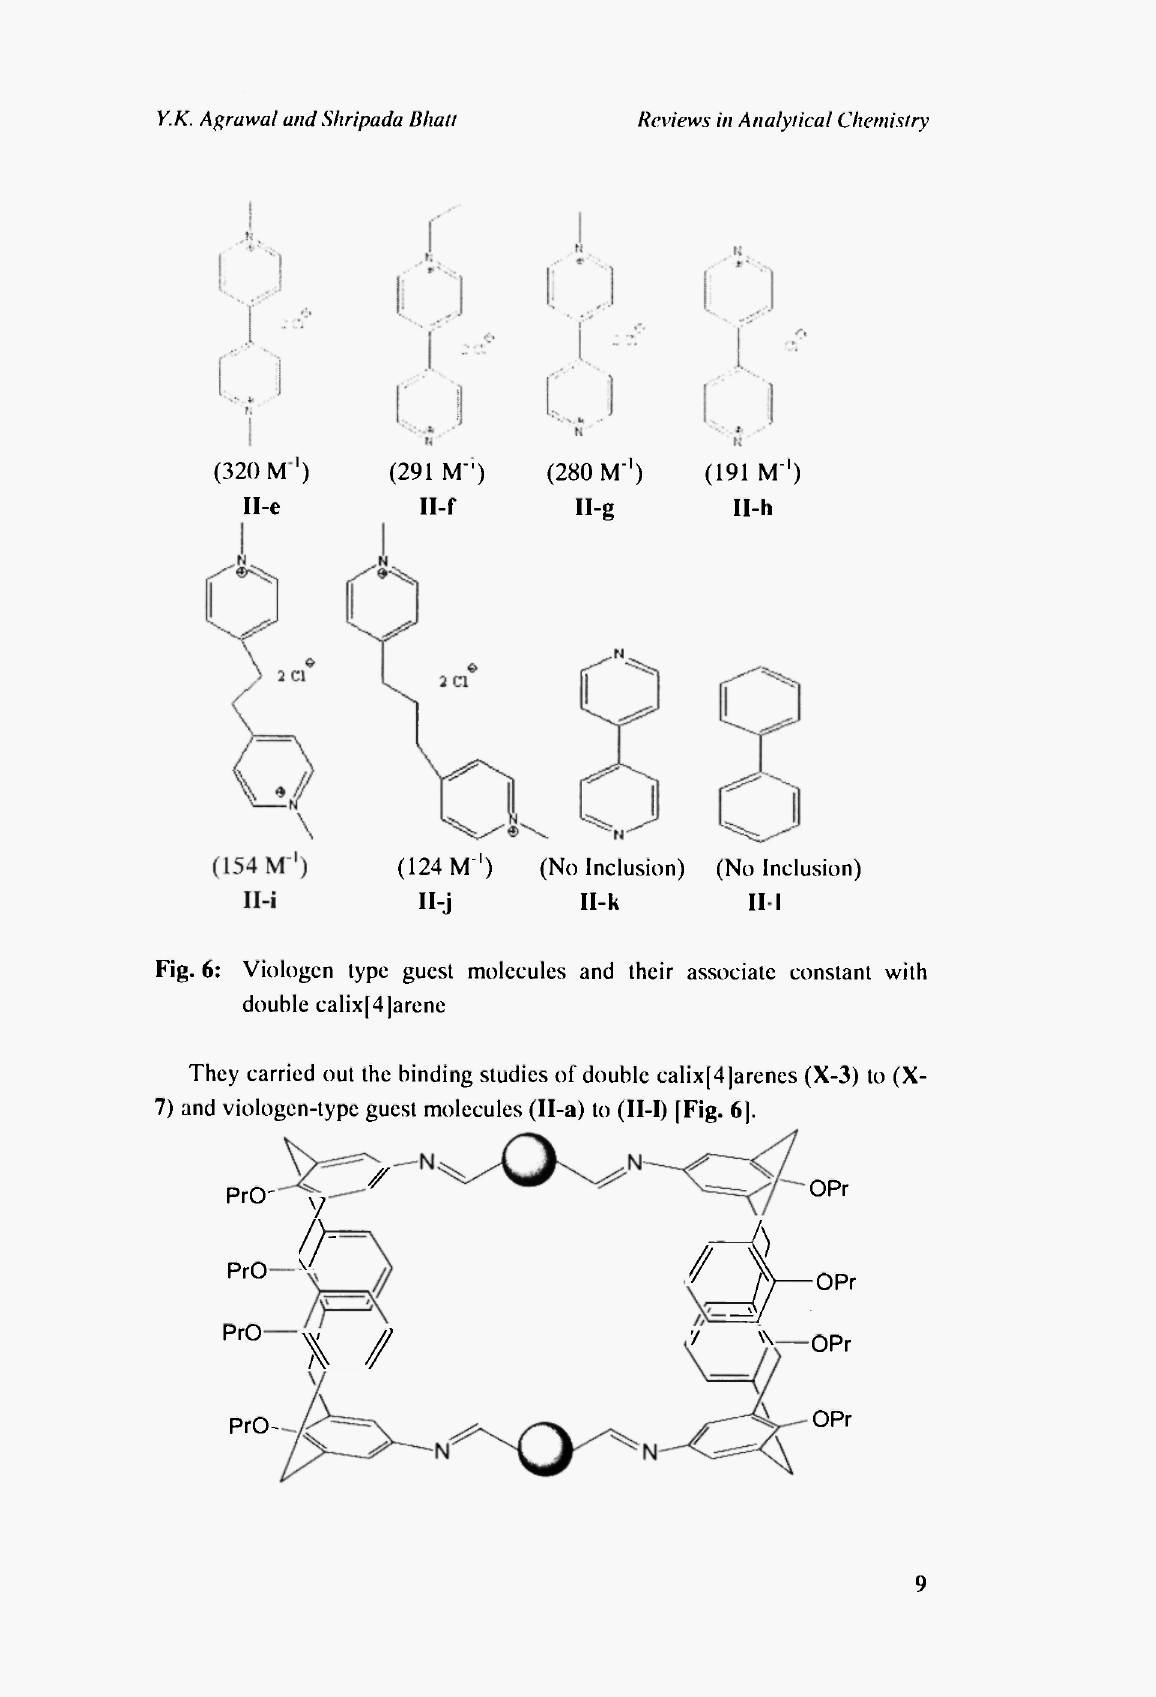
Fig. 6: Viologcn type guest molecules and their associate constant with double calix[4]arene